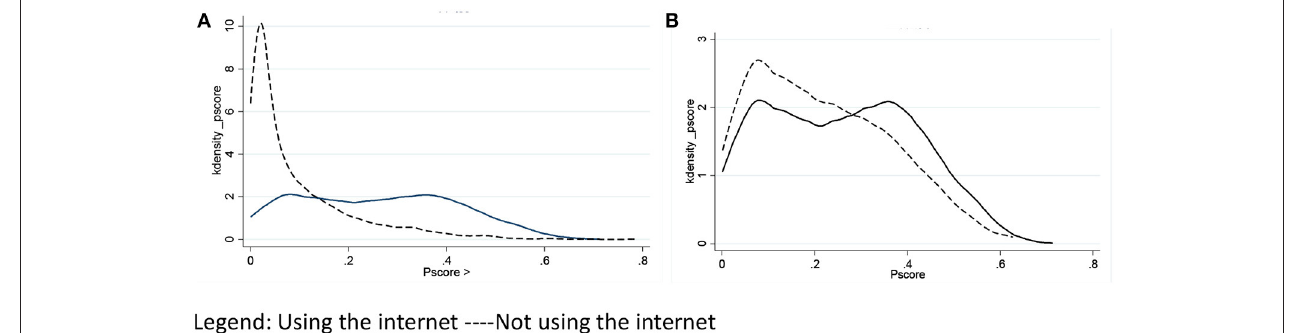
FIGURE 1 | Kernel density maps: (A) before matching; (B) after matching. Using the internet—Not using the internet.